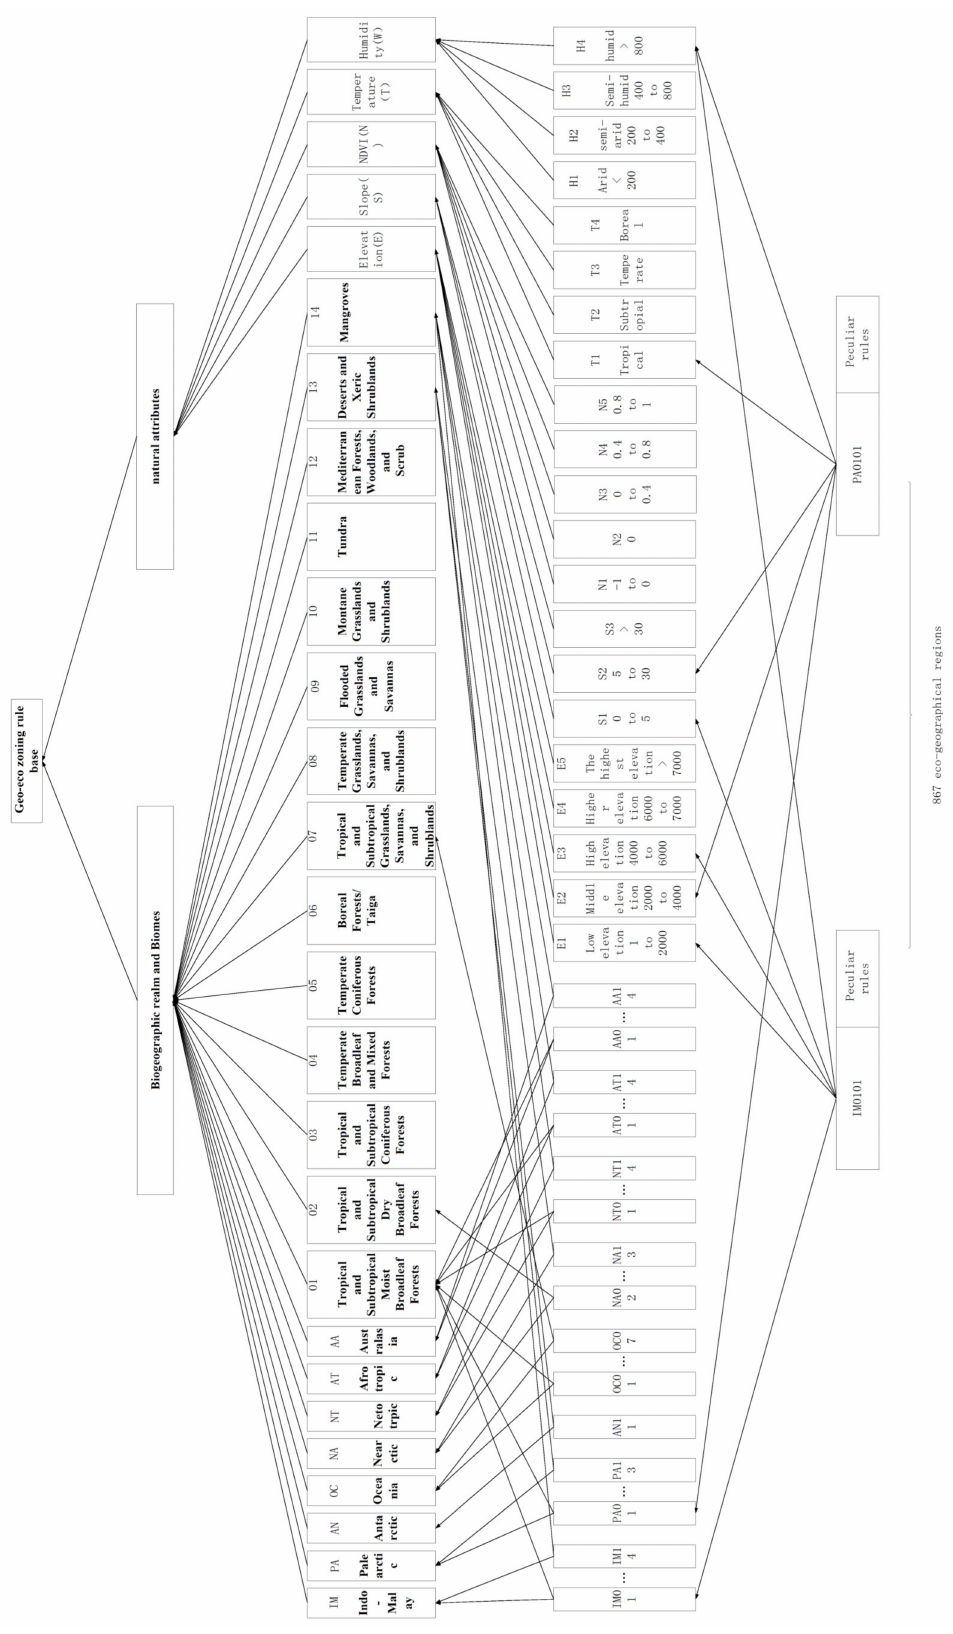
Figure 4. Framework of the global eco-geographical zone rule base (from Zhu et al.